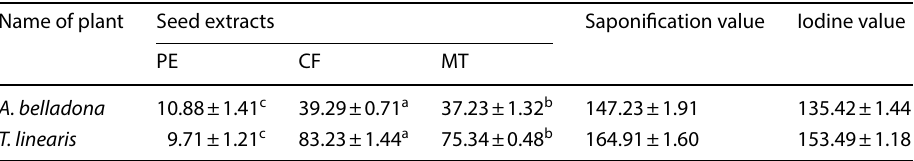
Table 1 Saponification and iodine values of petroleum ether extracts of A. belladonna and T. linearis and percentage yield (%, w/w ) of other seed extracts PE petroleum ether extract, CF chloroform extract, MT methanol extract. Data is expressed as mean ± SD (n = 3). Different letters in each row are significantly different (P < 0.05) by Tukey’s